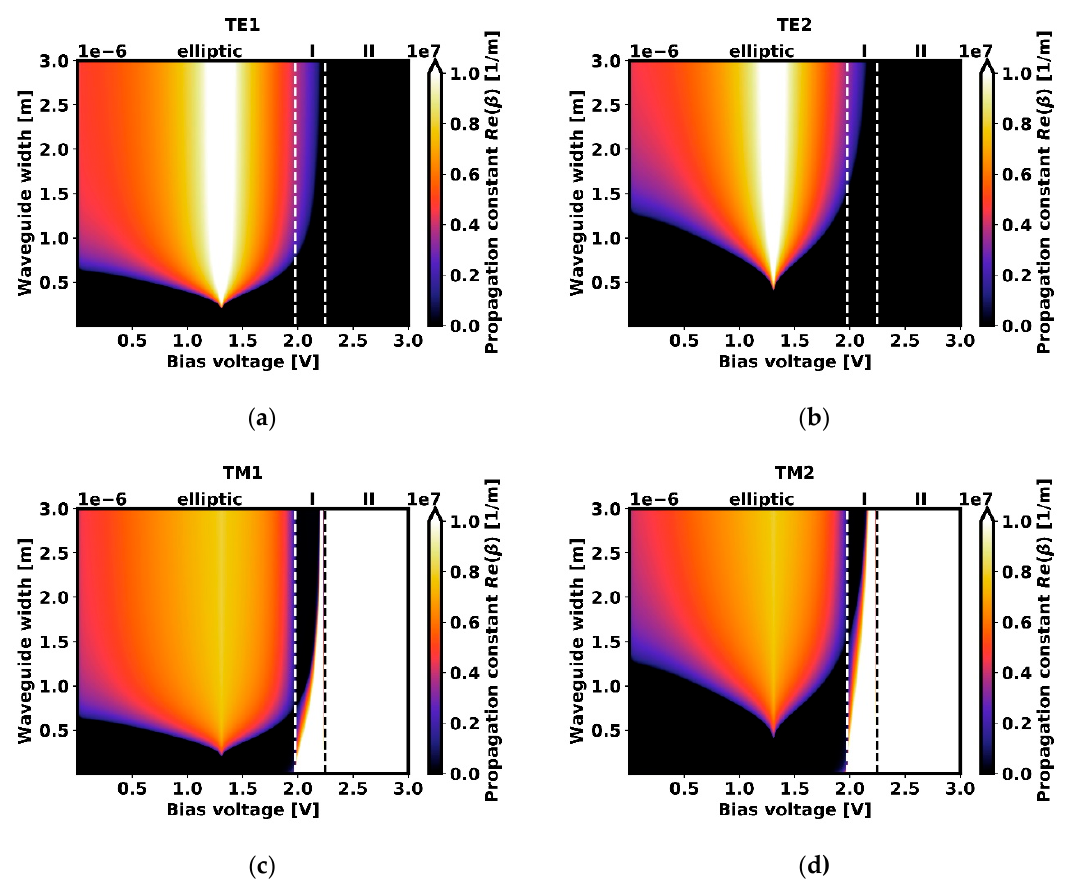
Figure 4. Propagation constant for configuration A as a function of the waveguide width d and the applied bias voltage V b , at 1.55 µm for first and second order TE ( a , b ) and TM ( c , d ) modes. Black areas indicate regions where propagation is forbidden.